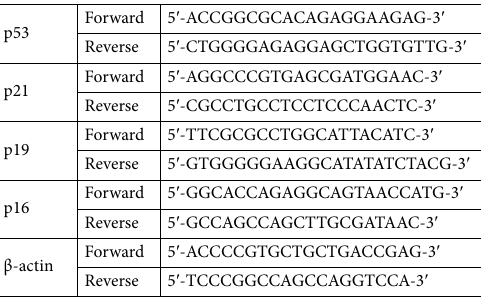
Table 1. Primers used in Real-time quantitative